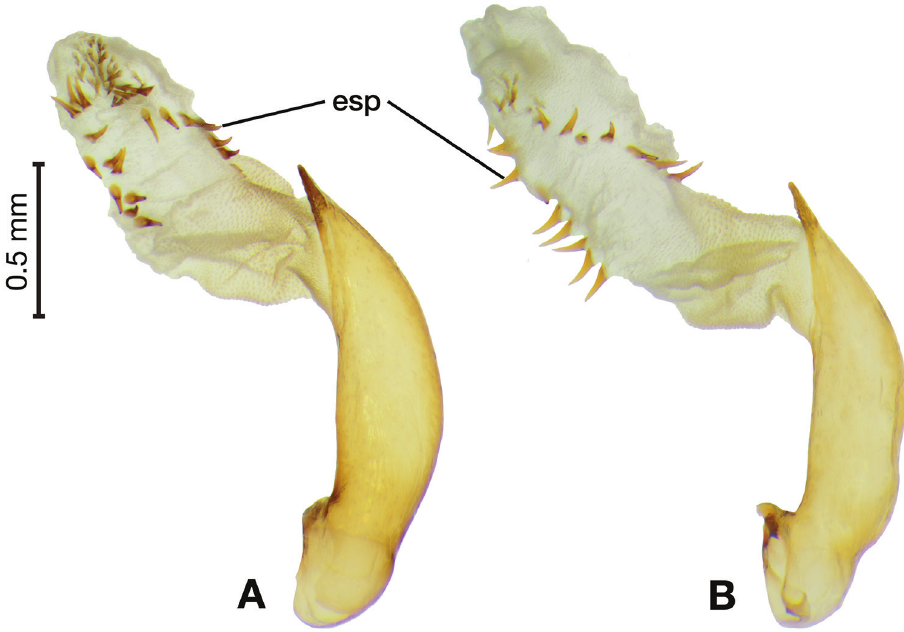
Figure 37. Digital images showing intrapopulation variation of form and number of endophallic spines of C. ( Coptoderina ) chaudoiri Andrewes, right lateral aspect, endophallus everted. A heavily sclerotized spines with many additional spines towards apex of endophallus B lightly sclerotized spines with fewer spines near apex of endophallus. Legend: esp endophallic